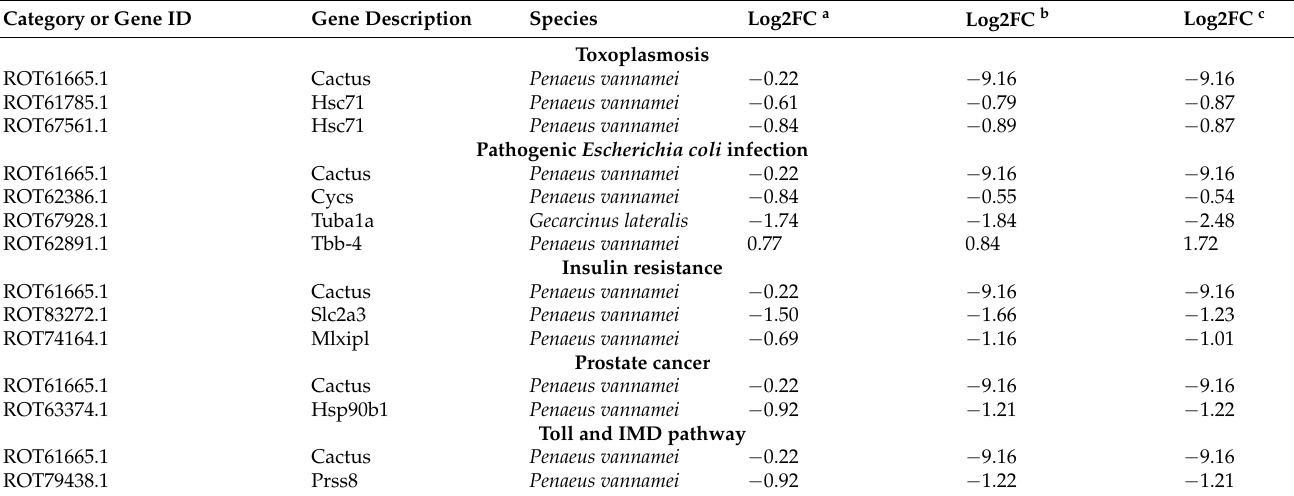
Figure 5. KEGG enrichment analysis of DEGs containing CPC-fed L. vannamei and FM groups. Highly expressed biological pathways in the transcriptome were retrieved from the KEGG database. DEGs were assigned to six specific KEGG pathways, including organismal systems, metabolism, genetic information processing and environmental information processing, cellular processes, and human diseases. Table 6. Cactus genes and the related